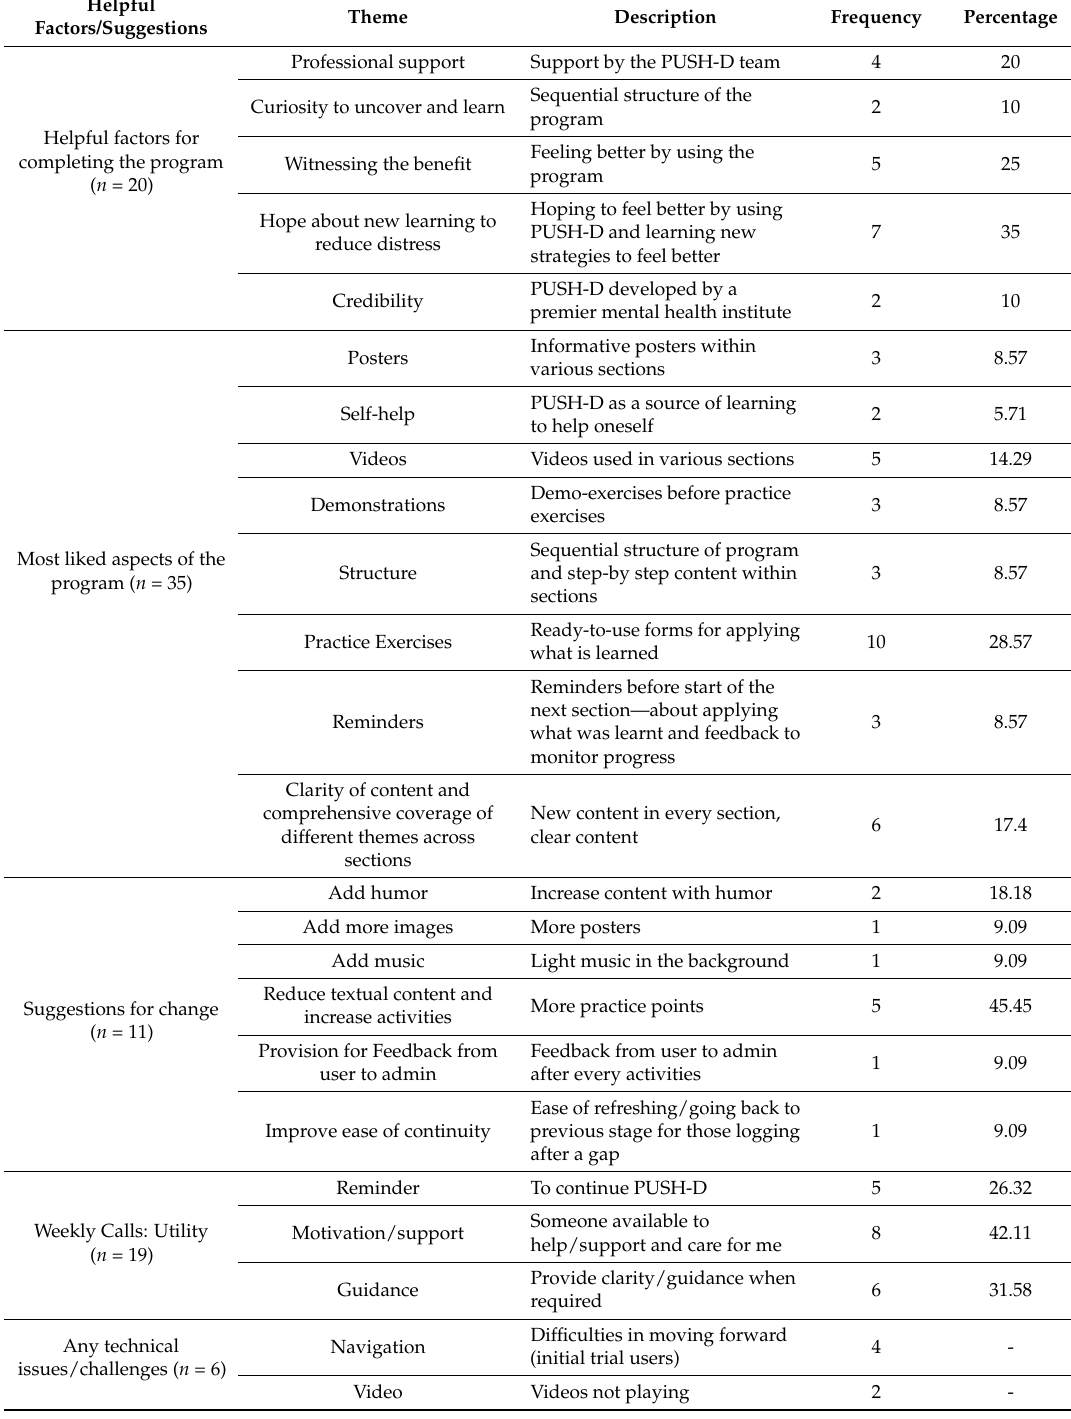
Table 9. Helpful factors and suggestions as perceived by the